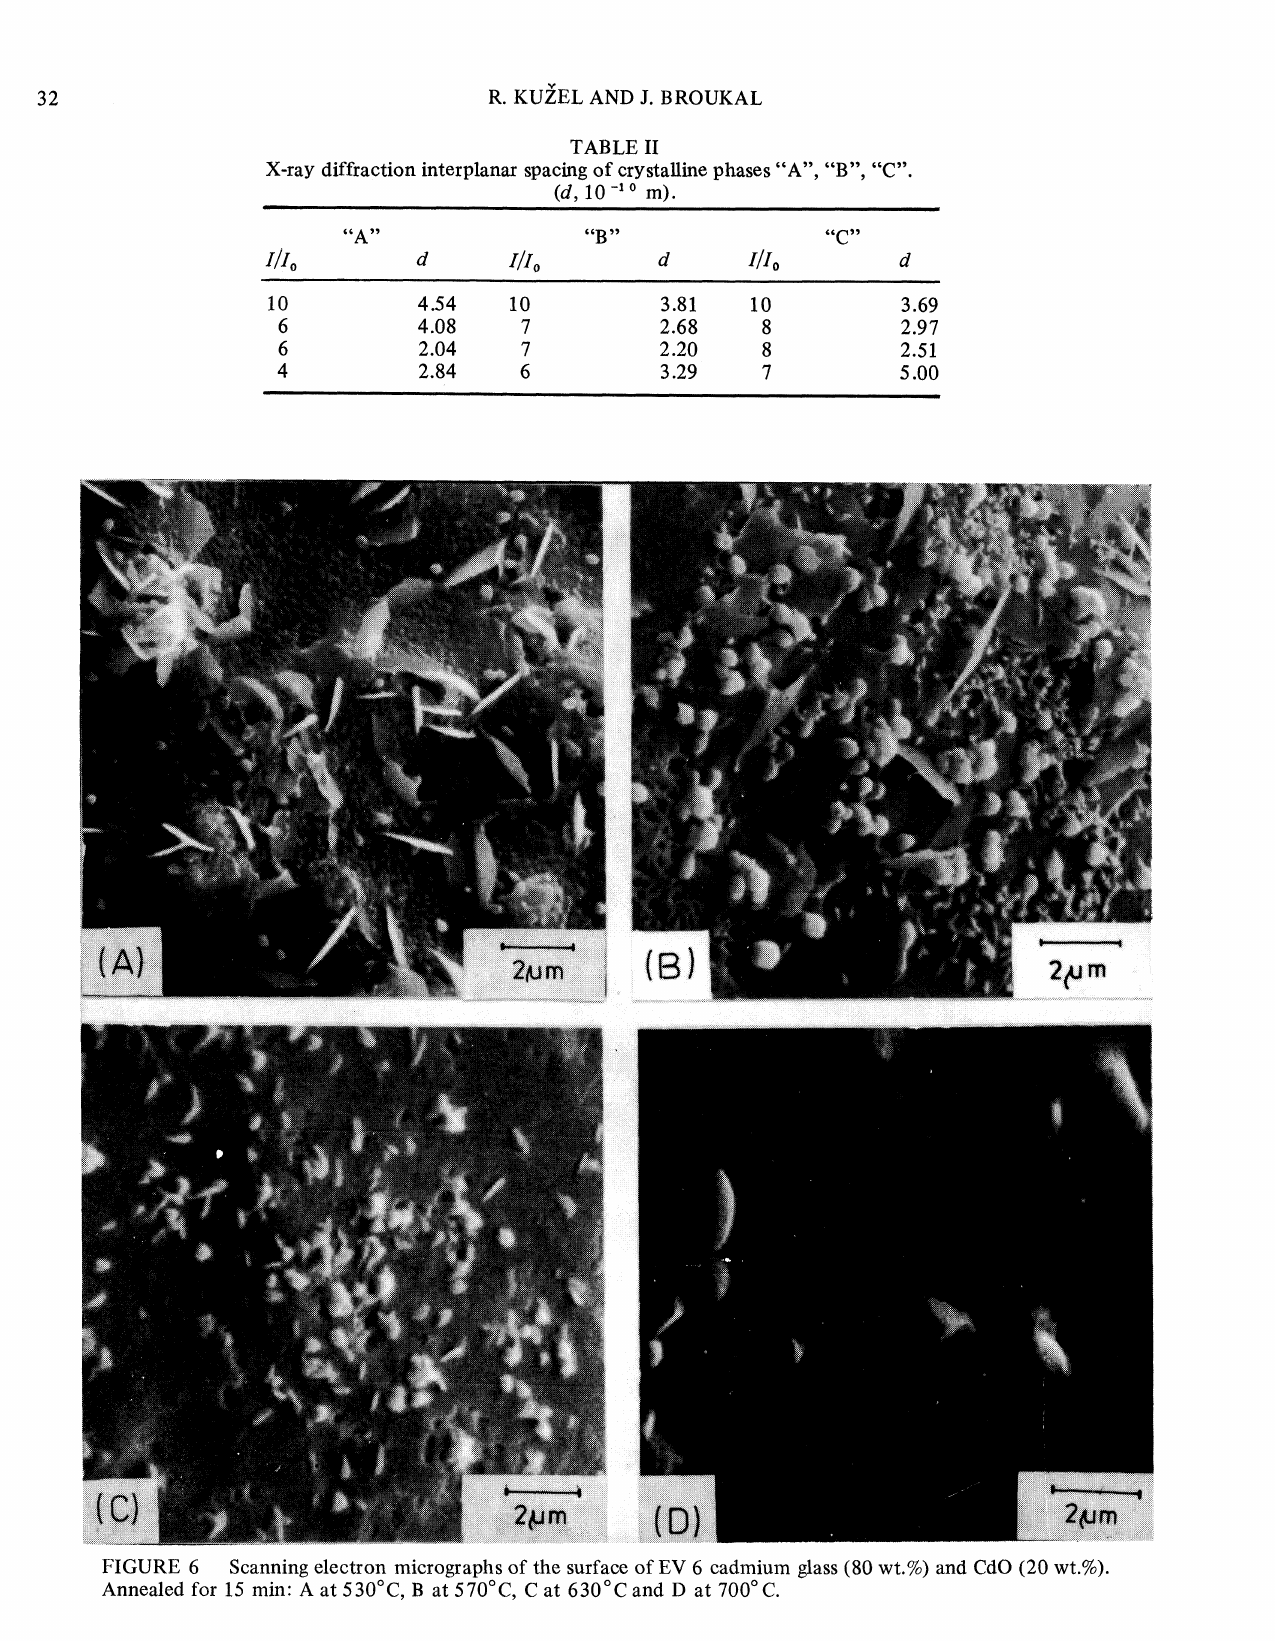
FIGURE 6 Scanning electron micrographs of the surface of EV 6 cadmium glass (80 wt.%) and CdO (20 wt.%). Annealed for 15 min" A at 530C, B at 570C, C at 630C and D at 700